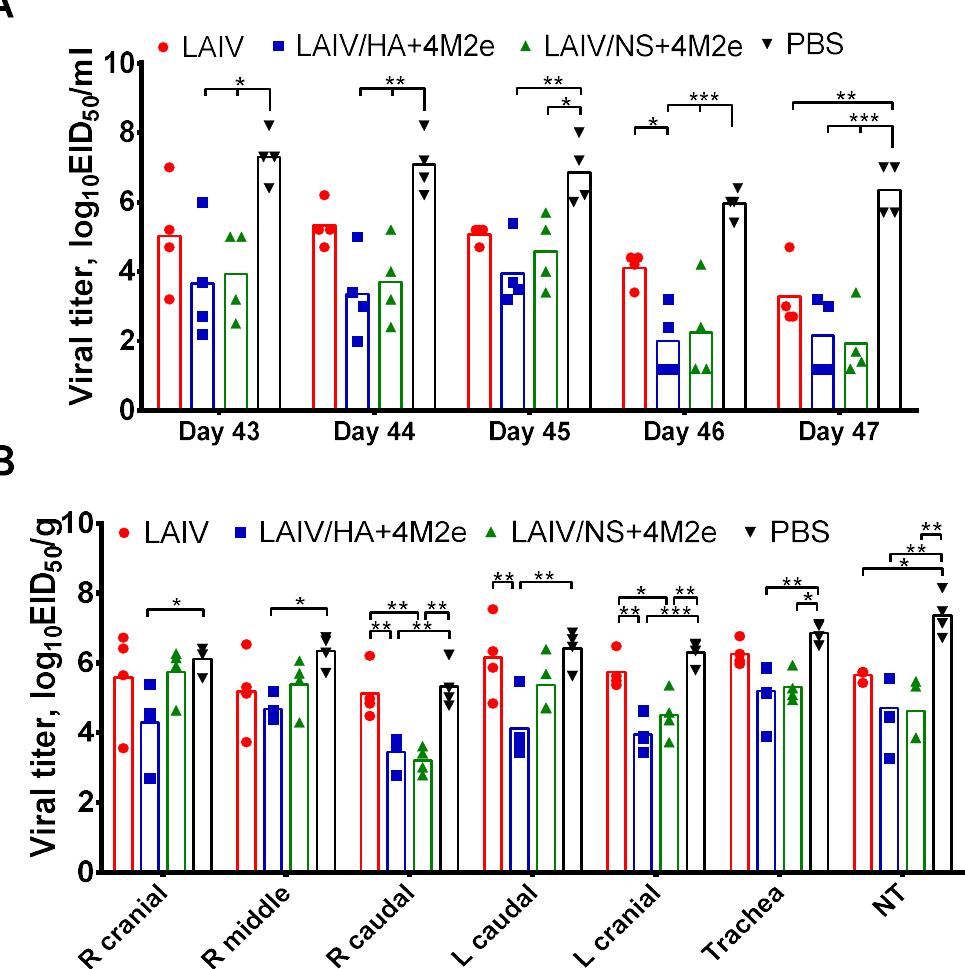
Figure 8. Replication of H1N1 challenge virus in the respiratory tract of immunized ferrets. Groups of four ferrets were infected i.n. with 10 6 log 10 EID 50 of S.A. H1N1 challenge virus three weeks after the second vaccine dose. ( A ) Nasal wash specimens were collected daily after the challenge and infectious viral titers were determined in eggs and expressed as log 10 EID 50 /mL. ( B ) Small pieces of tissues (nasal turbinates, trachea and lungs) were collected from euthanized ferrets five days post-challenge. Lung tissues were collected from five lung lobes separately for each animal. Viral titers in tissue homogenates were determined by titration in eggs and expressed in log 10 EID 50 /gram tissue. Data were analyzed by two-way ANOVA with Tukey’s post-hoc multiple analyses test. * p < 0.05; ** p < 0.01, *** p < 0.001.